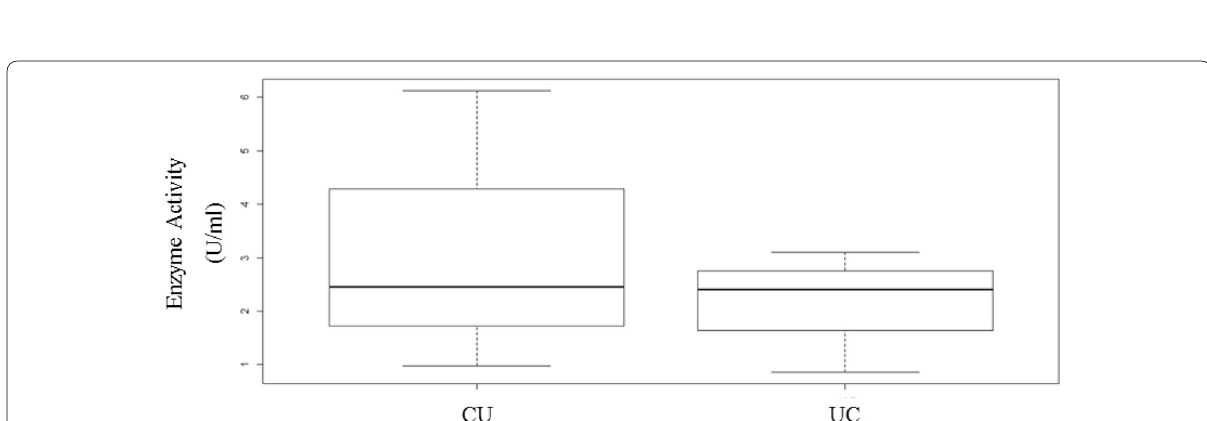
Fig. 5 Comparison of uricase activity of CU and UC chimaeras to investigate the effects of tag on uricase activity. A non-parametric two-sample Wilcoxon test was used to compare the results ( p <